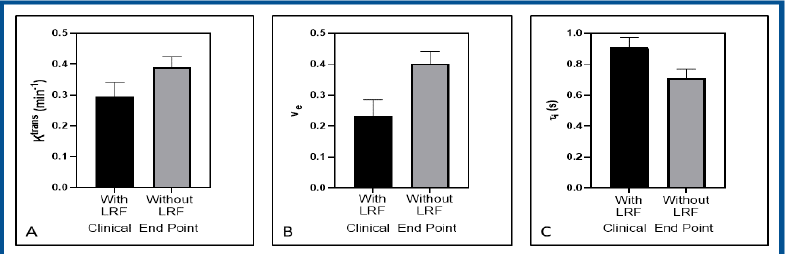
Figure 4. Bar plot comparing the mean value of ( A ) volume transfer constant (K trans ), ( B ) extravascular extracellular space volume fraction (v e ), and ( C ) mean lifetime of intracellular water protons ( τ i ) from fast exchange regime model between patients with and without locoregional failure (LRF) of nasopharyngeal carcinoma. The metric v e exhibited a significant difference between patients with and without LRF. K trans and τ i showed little significance ( p = 0.14 for K trans and p = 0.11 for τ i ). Table 3. Summarizes the FXR DCE-MRI-derived metric